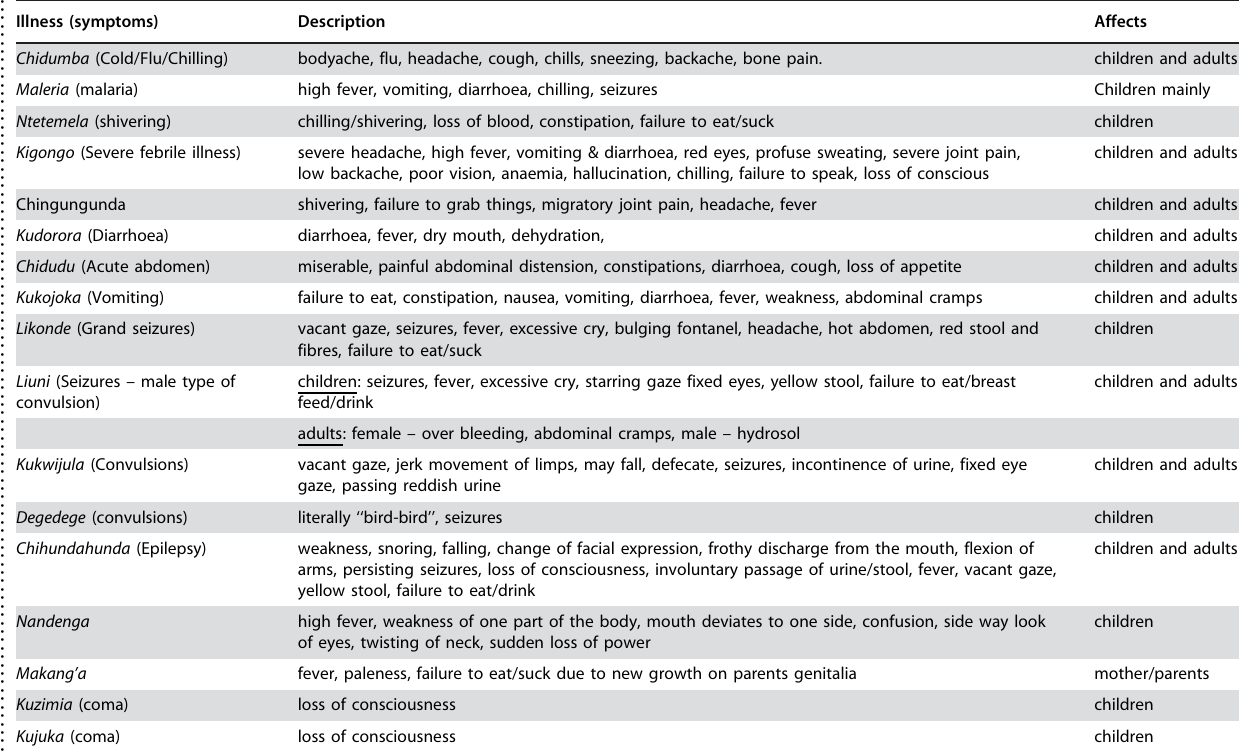
Table 3. Local terminology of common illnesses in the study community and their descriptions .. ... .... ... ... .... ... ... .... ... ... .... ... ... .... ... ... .... ... ... .... ... ... .... ... ... .... ... ... .... ... ... .... ... ... .... ... ... .... ... ... .... ... ... .